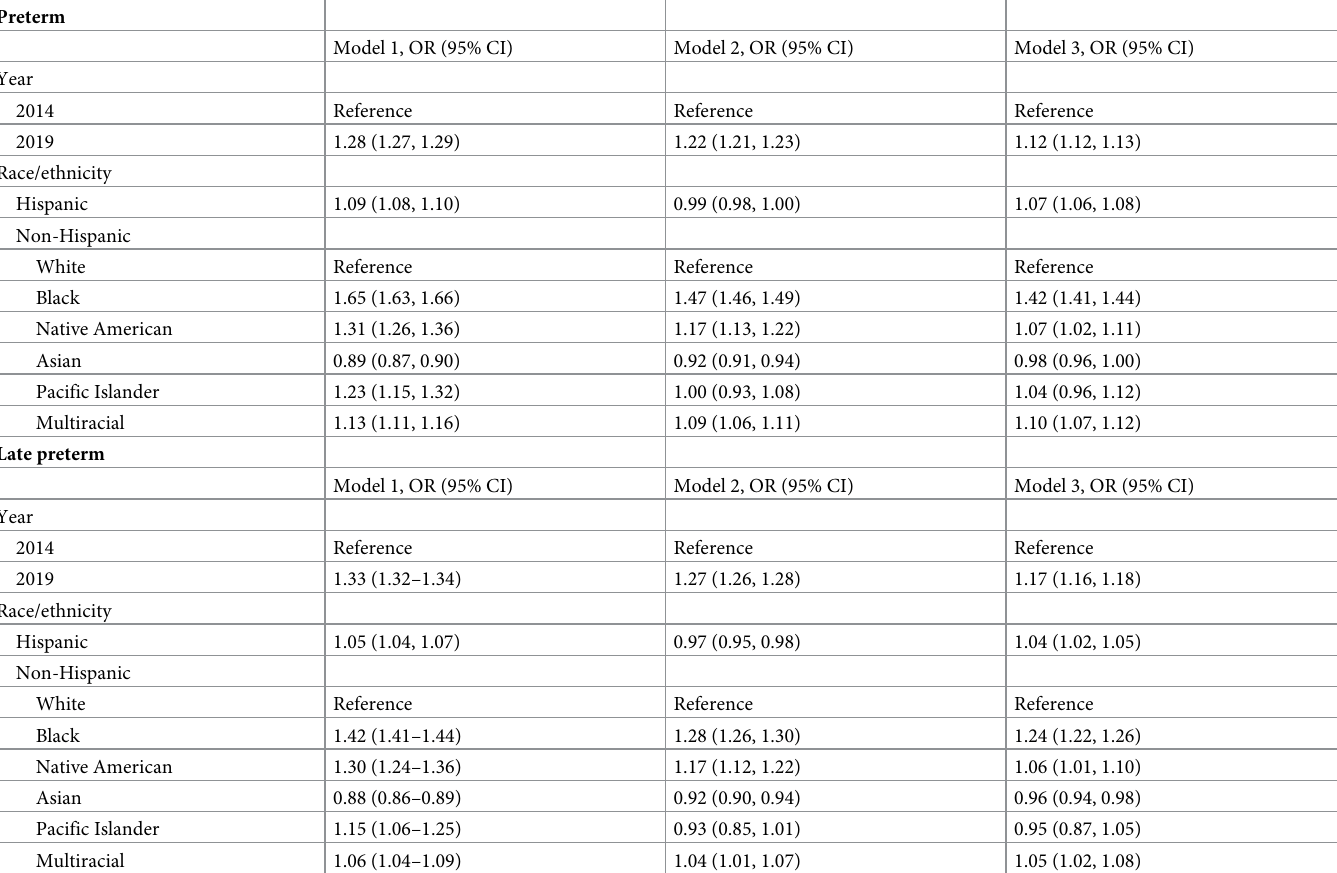
Table 3. Odds ratios for preterm obstetrical intervention (no labor cesarean or induction of labor) by race/ethnicity, United States, 2014 and 2019.